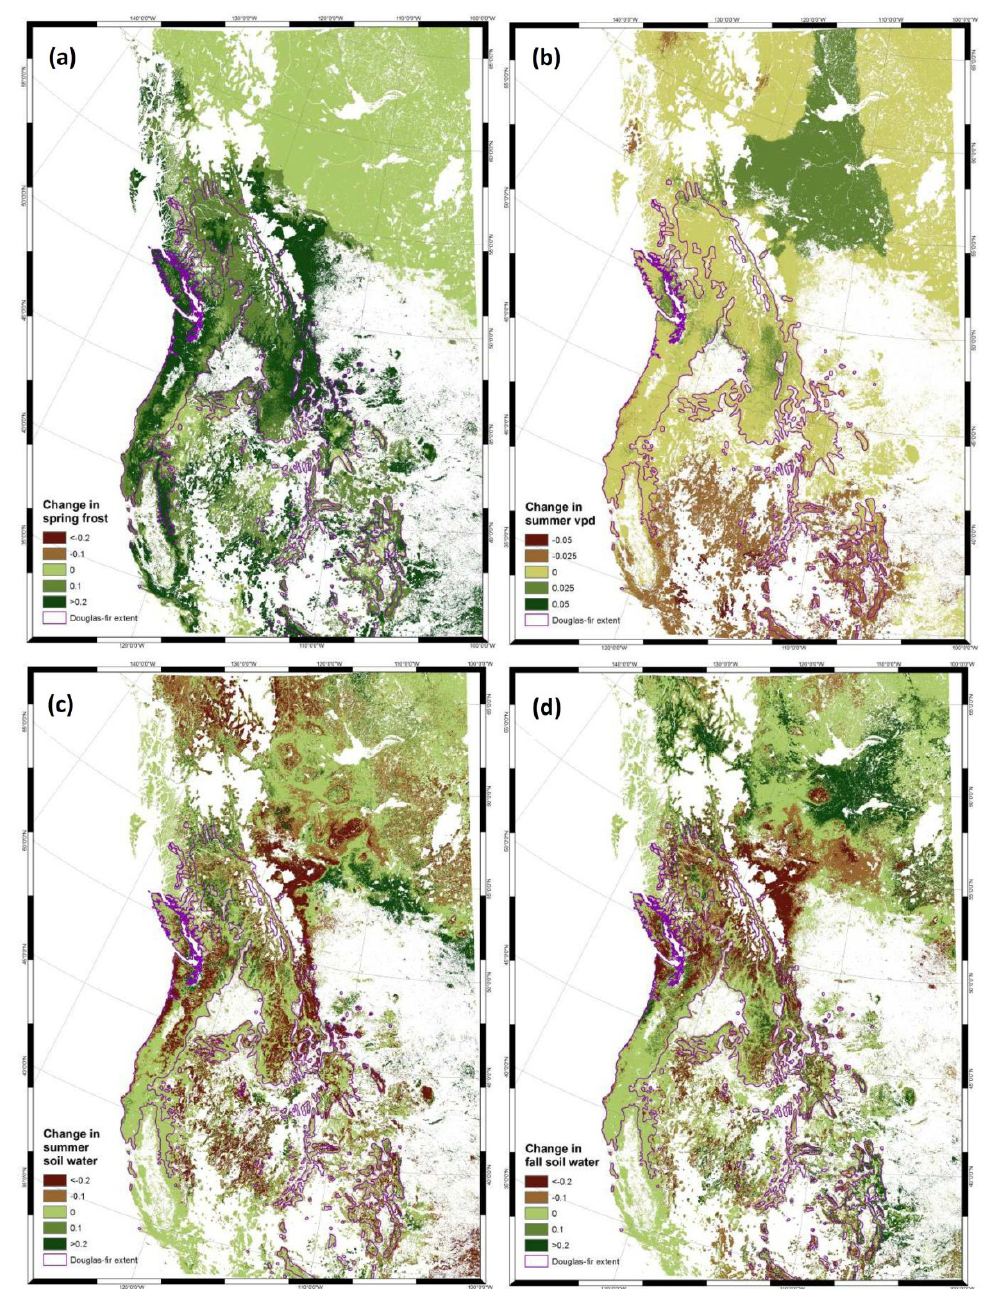
Figure 3. Modeled average changes from 2000 to 2009 in ( a ) spring frost frequency, ( b ) summer evaporative demand, ( c ) summer soil water stress and ( d ) fall soil water stress compared to the cooler and wetter period (1950–1975). The units represent the proportional change in environmental constraints on GPP in reference to the first period. The range of Douglas-fir is from